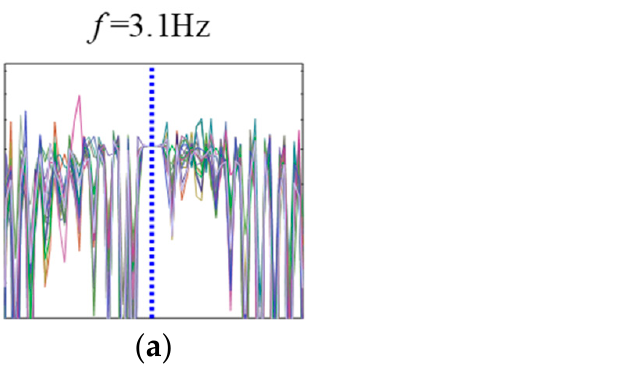
ij t of response in a finite time period (19 groups). 34